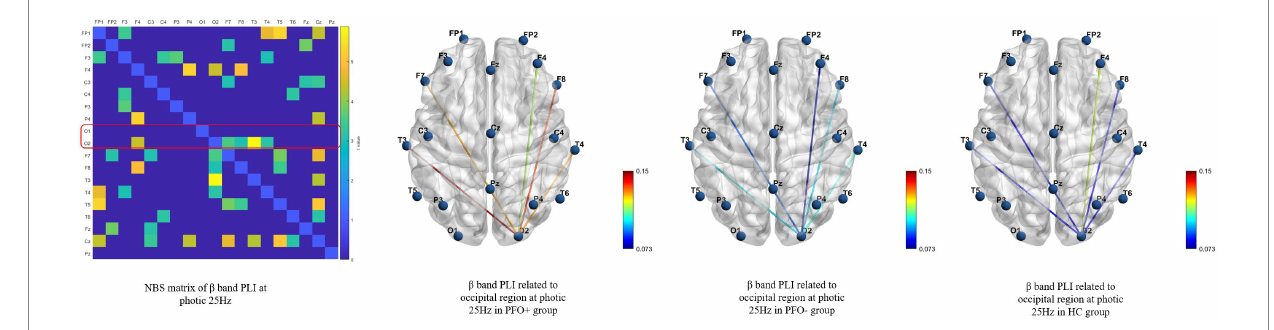
FIGURE 3 Network-based statistics (NBS) results of the beta band phase lag index (PLI) during photic stimulation among PFO + group ( n = 35), PFO-group ( n = 35) and Control group ( n = 20) during photic stimulation at 25 Hz. The matrix graphs show a significant difference of the beta band PLI between the three groups, whereas the brain connectivity graphs show that the beta band PLI between the occipital region and other regions was increased in the PFO + group compared to the PFO-group.